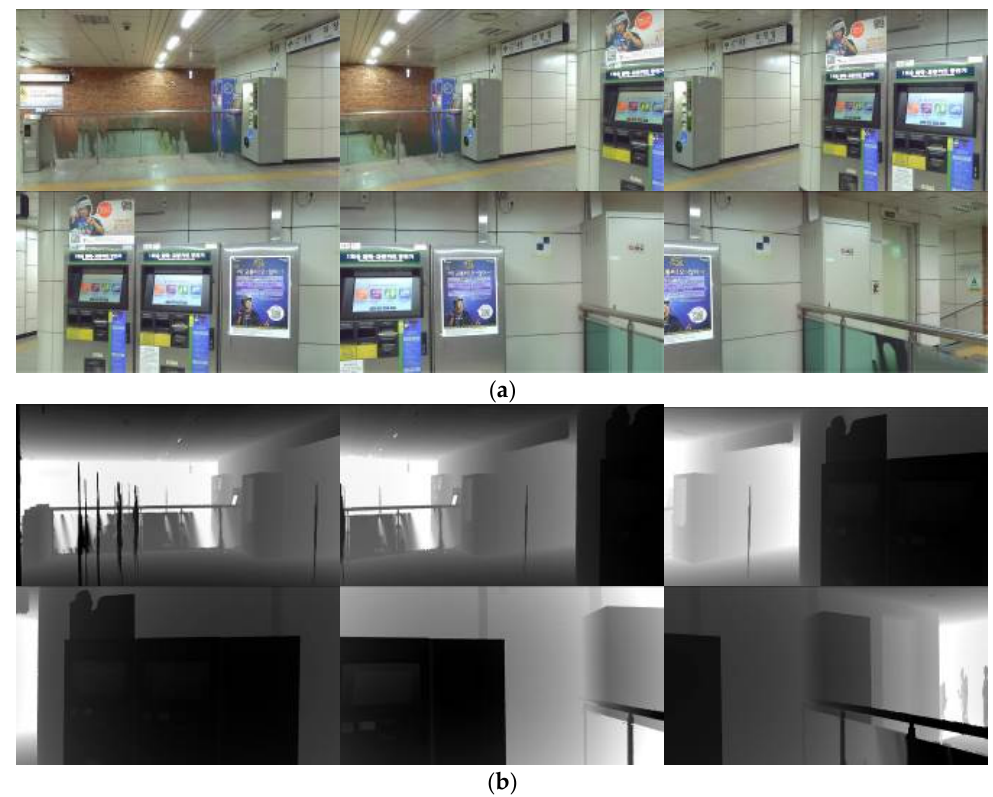
Figure 5. ( a ) Example of six RGB-D images generated with the software ScanToRGBDImage in RGB visualization; and ( b ) example of six RGB-D images in a depth map visualisation. visualization; and ( b ) example of six RGB-D images in a depth map